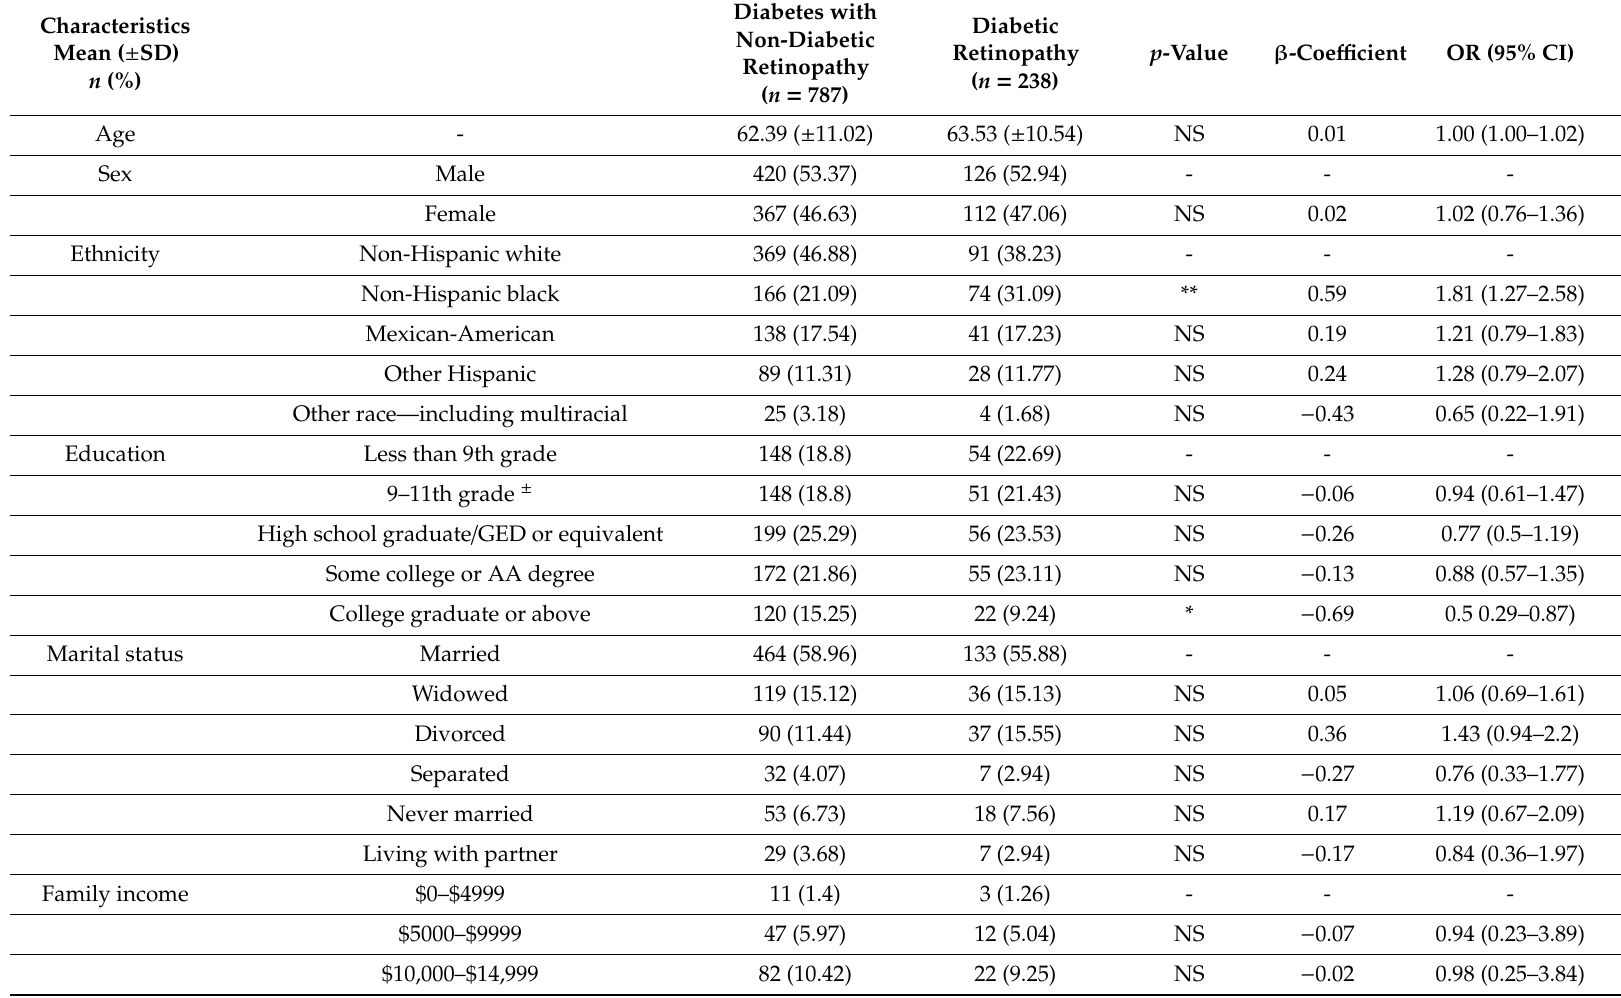
Table 1. Demographic overview of study